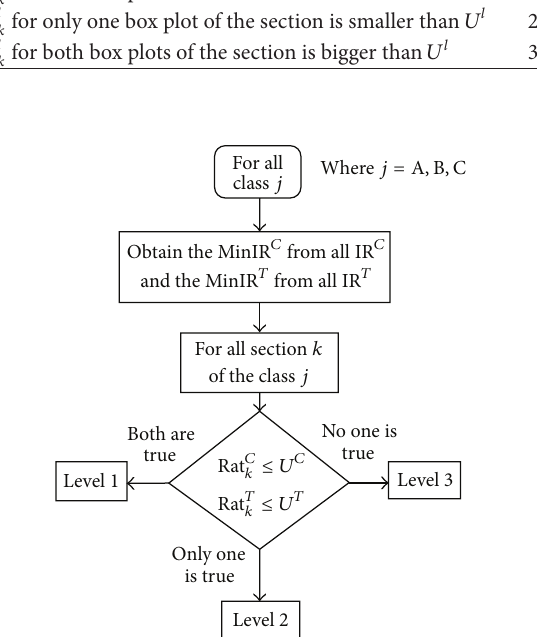
Figure 5: Flowchart for the second phase of the section classifying